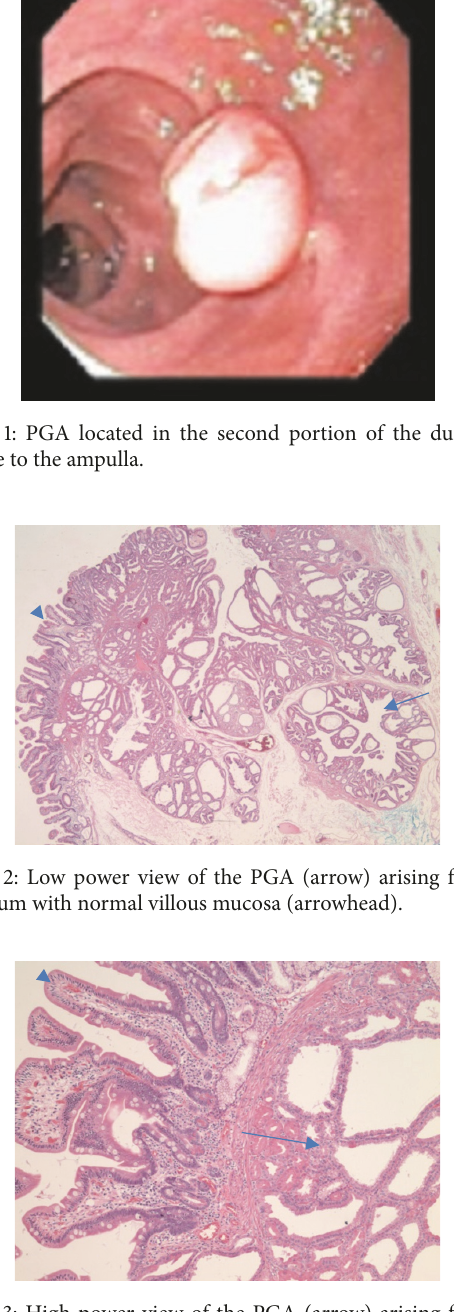
Figure 3: High power view of the PGA (arrow) arising from the duodenum with normal villous mucosa (arrowhead).